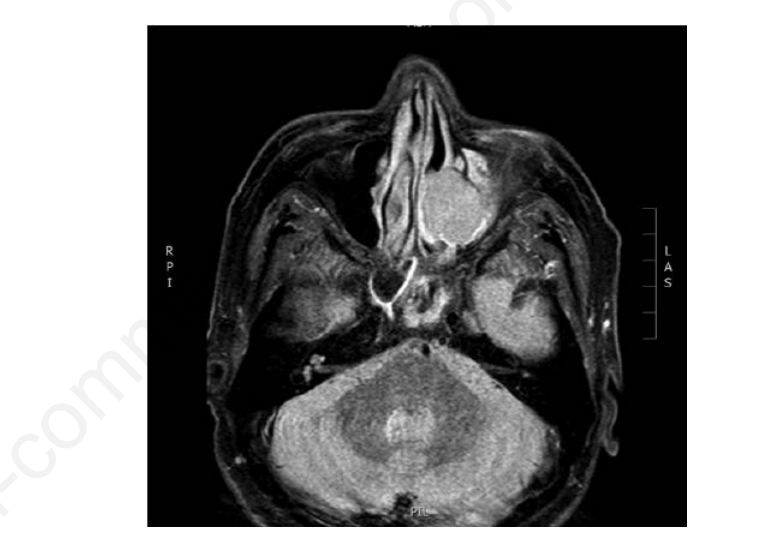
Figure 1. MRI STIR sequence of patient number 8 showing nasal extramedullary plasma- cytoma.